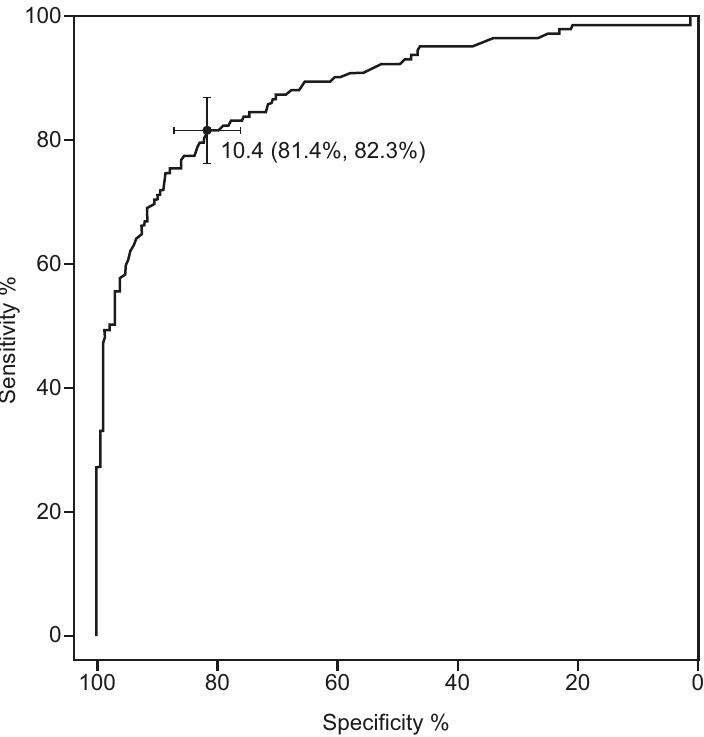
Fig 4. Receiver-operator characteristic (ROC) curve analysis of FSH as predictor of azoospermia (combined cohort: n = 367). Area under the curve: 0 (cid:1) 89 (95% CI 0 (cid:1) 85–0 (cid:1) 92.The optimaldiagnostic threshold is 10.4 mIU/mL, with sensitivity 0.814 and specificity 0.823.